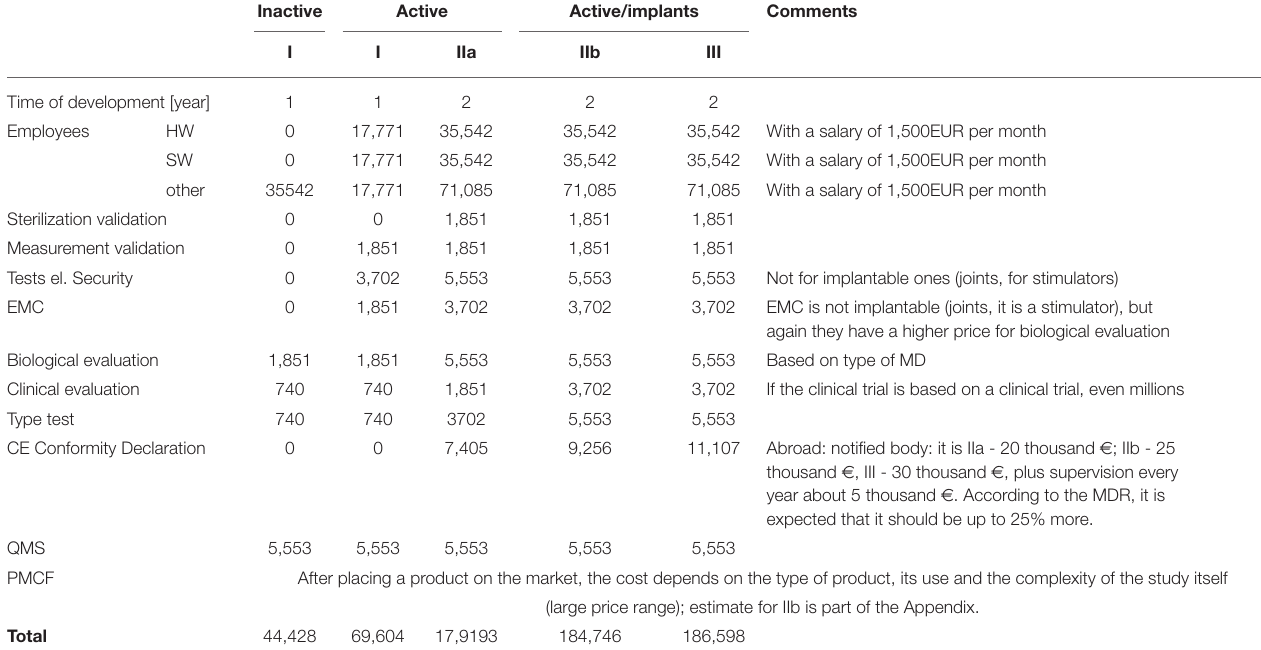
TABLE 3 | Approximate costs related to the development of MDs